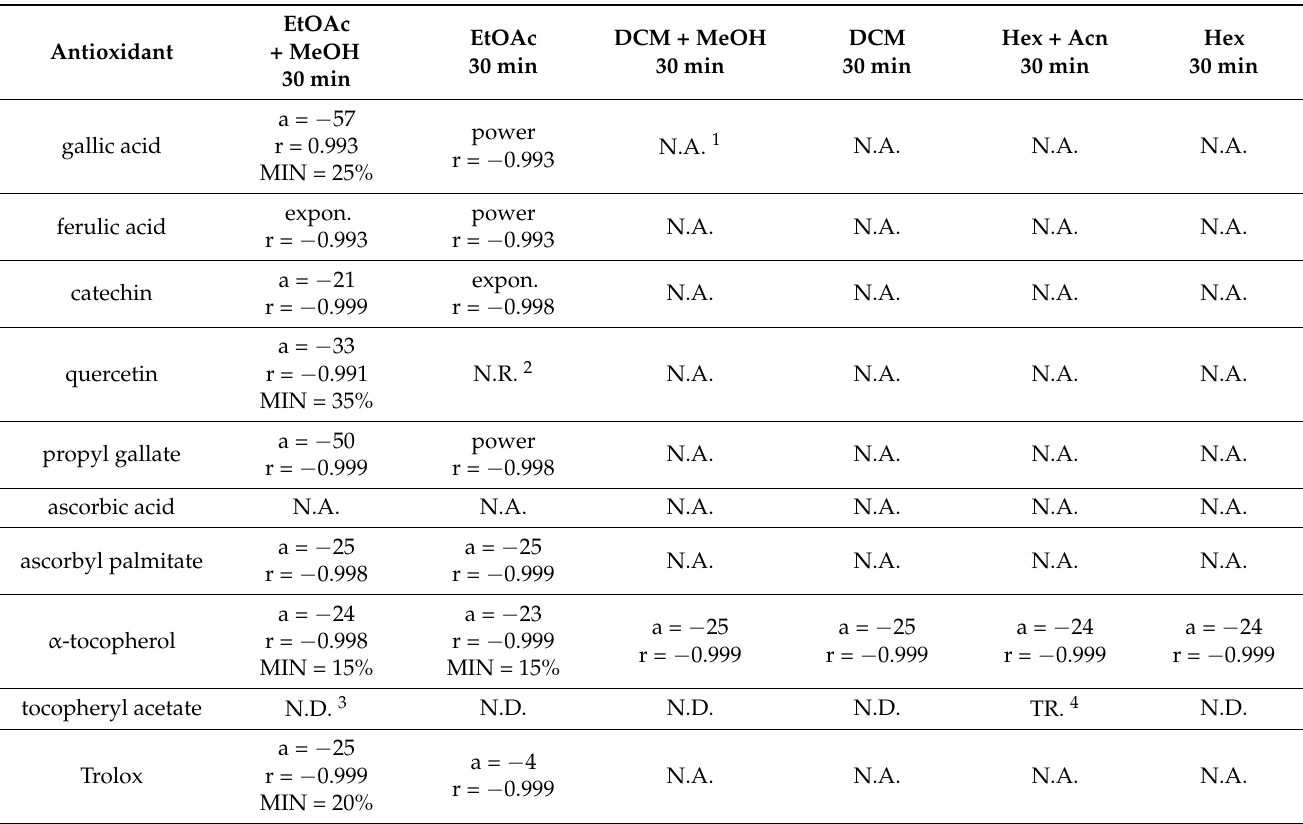
Table 4. Linear and non-linear relations obtained for different antioxidant concentrations ( µ M) applied against DPPH radicals in ethyl acetate (radical solution in methanol or ethyl acetate), dichloromethane (radical solution in methanol or dichloromethane) and hexane (radical solution in acetone or hexane) after standard reaction time. In case of linear relations, slope (a), correlation coefficient (r) and lower linearity limits if occurring (MIN–as % of A contr ) were shown; in case of a non-linear relationship, equation type and correlation coefficient were